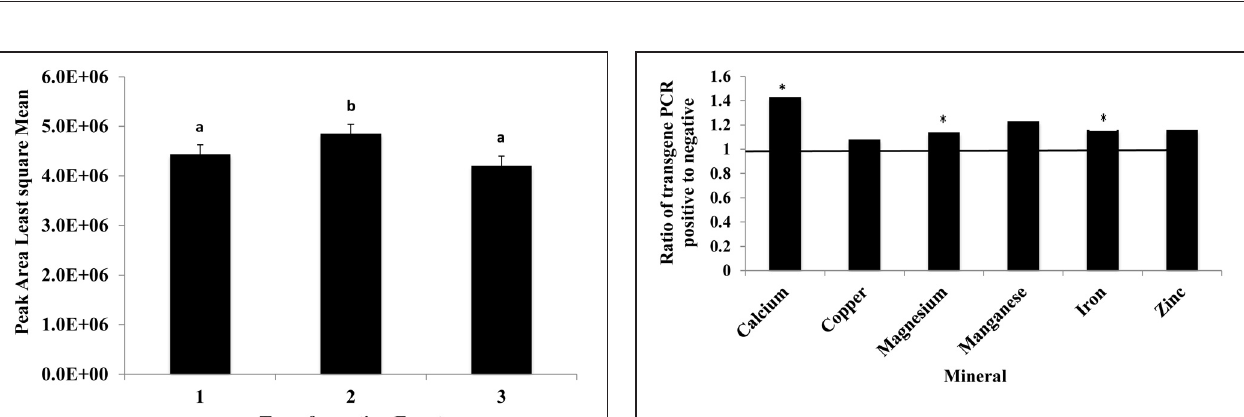
FIGURE 8 | Fold change in mean mineral concentration in maize seed samples transformed with the soybean ferritin transgene. The samples were screened with PCR to categorize them into those positive and negative for the soybean ferritin transgene. Three transformation events (P344-2-4-1, P344-4-1-6, and P344-5-2-1) were used for this test. The event effect was not significant (data not shown), therefore, the results presented are from combined data. The horizontal line represents normalized values for the transgene PCR negative samples. Significant differences ( P < 0 . 05) are indicated with a star on top of each error bar for which the PCR positive and negative samples